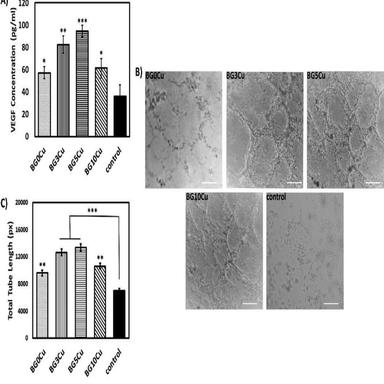
(A) The vascular endothelial growth factor secretion of human umbilical vein endothelial cells cultured in different extracts of the modified bioactive glasses (BGs) for 7 days was determined by the ELISA analysis, indicating that the BG3Cu and BG5Cu glasses significantly enhance the vascular endothelial growth factor secretion. (B) A tube formation analysis of different extracts of the modified BGs on Matrigel after incubation for 12 h (Scale bar ¼ 200 mm). (C) Quantification of the total tube length of hu